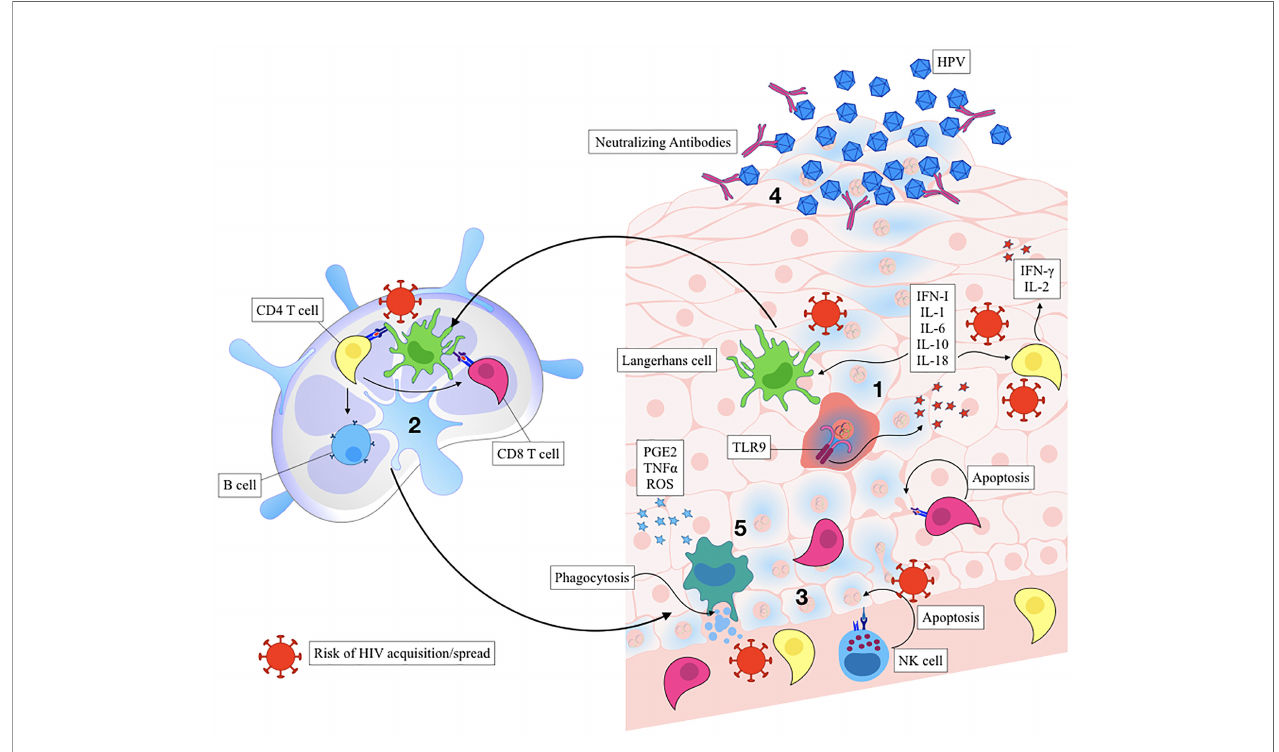
FIGURE 2 | Immune control of HPV infection and the risk of HIV acquisition. Activated keratinocytes trigger the release of pro-in fl ammatory cytokines and chemokines leading to recruitment of Langerhans cells and other antigen-presenting cells (APCs) (Step 1). In fl ammation is a known risk for HIV acquisition. Activated APCs process the antigen and migrate to the draining lymph node, where they help activate antigen speci fi c CD8 + , CD4 + , and B cells (Step 2). HIV can utilize immune cell traf fi cking to spread from APCs to T Cells. The in fl ammatory state also activates innate immune responses, such as natural killer cells (Step 3), also associated with the increased risk of HIV acquisition. In fl ammation drives in fi ltration of CD8 + T cells that kill viral-infected cells, and CD4 + T that contribute to viral clearance while also serving as HIV target cells. Plasma cells secrete neutralizing antibodies that function to neutralize cell-free HPV, preventing further infectious spread (Step 4). Macrophages and dendritic cells induce apoptosis and phagocytose apoptotic bodies, producing anti-in fl ammatory mediators and initiating the healing process (Step